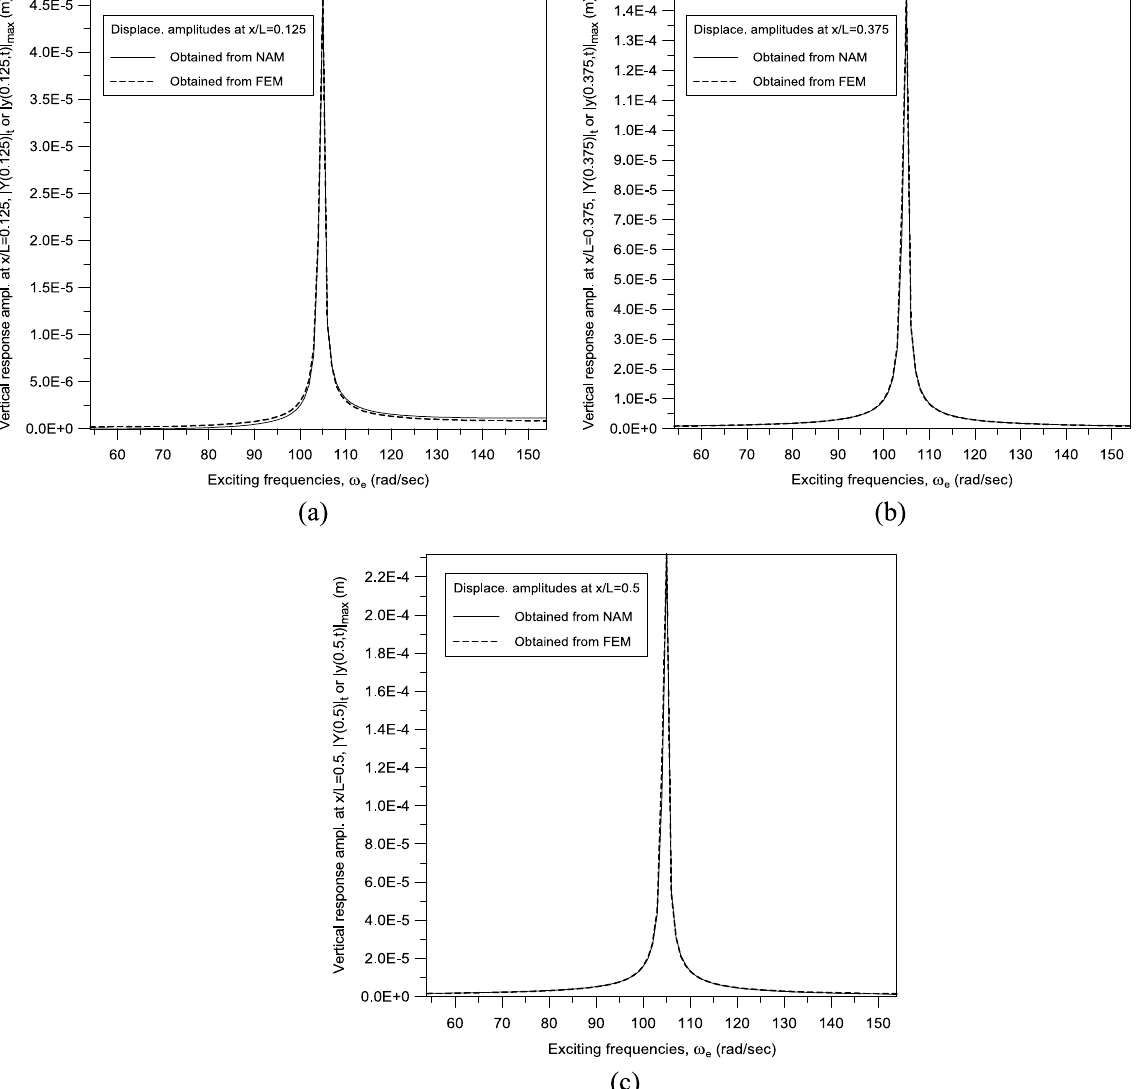
Fig. 9. The legend is the same as Fig. 7 except that this is for the vibrating system shown in Fig. 6(c). Besides, the equilibrium of shear forces and bending moments for the last two beam segments, ( i ) and ( i + 1), joined at node i requires